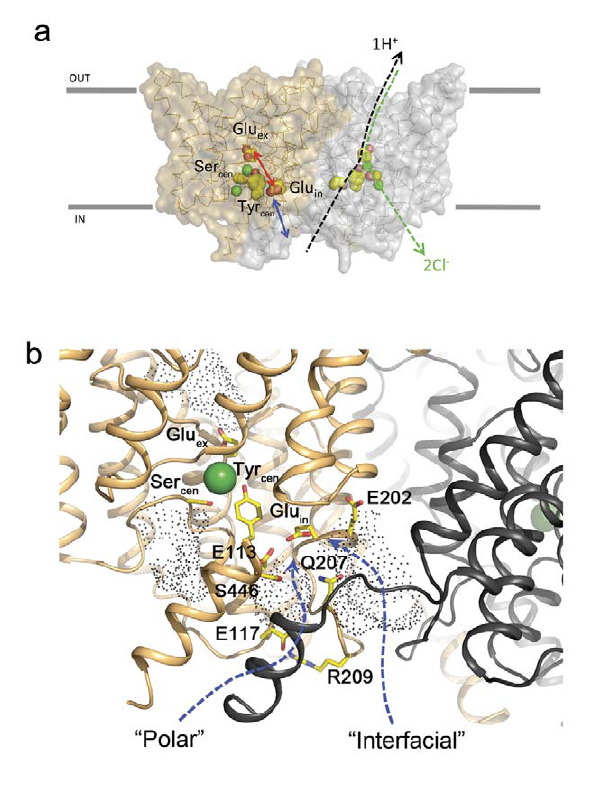
Figure 1. Ion transport pathways and solvent accessibility of CLC-ec1. (a) CLC-ec1 (PDB # 1OTS) is shown in surface view, with subunits of the homodimer differently colored and drawn to indicate different aspects of the antiport mechanism. Key mechanistic residues are space-filled. Bifurcated Cl 2 and H + pathways are indicated as dashed lines on right subunit. Separation of Glu in from the intracellular solution is shown with a blue arrow, central region between Glu in and Glu ex with a red arrow, and the internal and central Cl 2 ions as green spheres. In subsequent figures, the internal Cl 2 ion is omitted, since this binds weakly and is unlikely to be directly involved in the transport mechanism. (b) Close-up view of the intracellular surface of CLC-ec1 near Glu in . Aqueous clefts are shown as dots, and the twin subunit is shown in greyscale to visualize the subunit interface. Polar and interfacial pathways—possible routes for H + access to Glu in —are indicated with